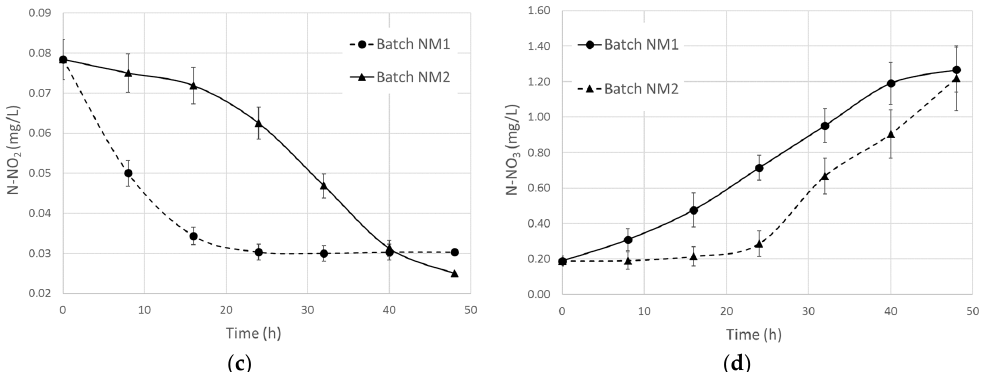
Figure 6. Effect of nitrification of municipal mixed liquor inoculated with R. capsulatus grown in aerobic-dark (batch NM1) and anaerobic-light (batch NM2) on ammonia ( a ) and SCOD ( b ) nitrate ( c ) and nitrite ( d ) concentration.